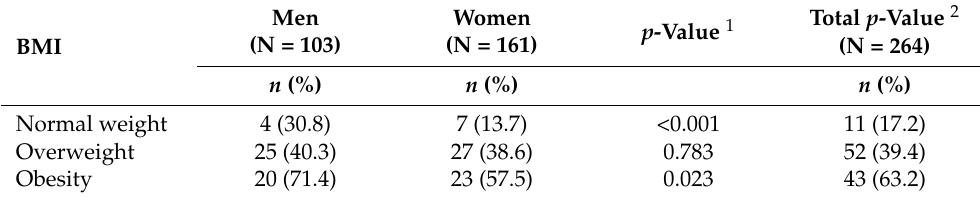
Table 2. Prevalence of metabolic syndrome by BMI and gender.